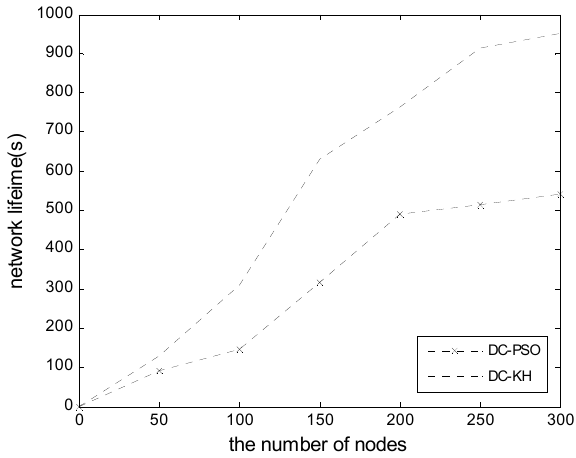
Figure 6. Network total energy consumption comparison chart.